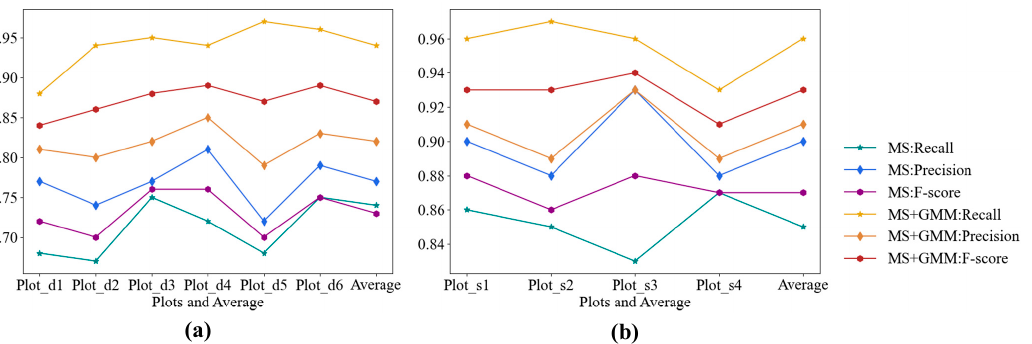
Figure 11. The line graph of Recall, Precision, F-score, and average values of the ten sample plots under different treatments, which intuitively shows the superiority of our treatment over ITS using MS alone can visually represent that the treatment in this paper has obvious advantages over using MS alone for ITS. ( a ) Trento dataset; ( b ) Qingdao dataset.